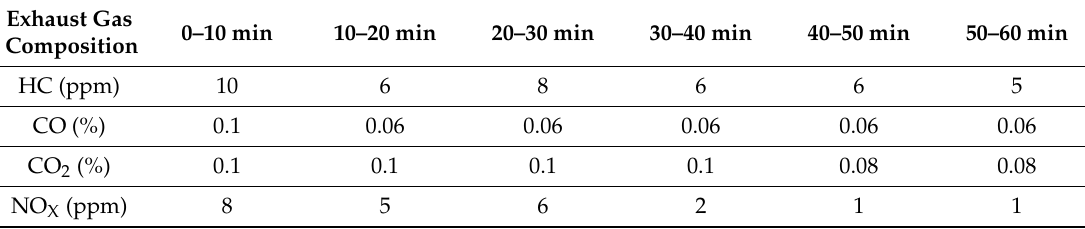
Table 3. Exhaust gas purification system error correction